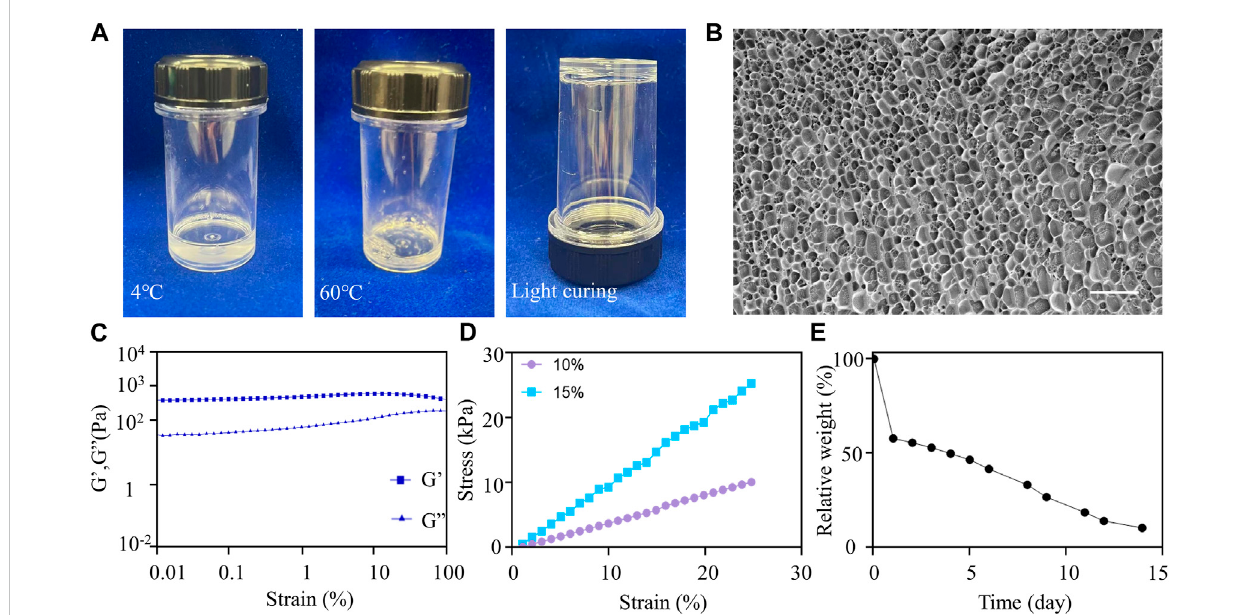
FIGURE 3 Material characterizationofF127DA. (A) F127DA became viscous as thetemperatureincreased and couldbelight cured. (B) Cryo-scanningelectron microscope image showing the inside structure of the hydrogel. Scale bar: 10 μ m. (C) Rheological tests showing that the hydrogel exhibited elastic solid behavior. (D) The compressive strength test showing the relationship between stress and strain of 10% and 15% F127DA hydrogel. (E) The variation curve of relative weight of the hydrogel with time at 37 °